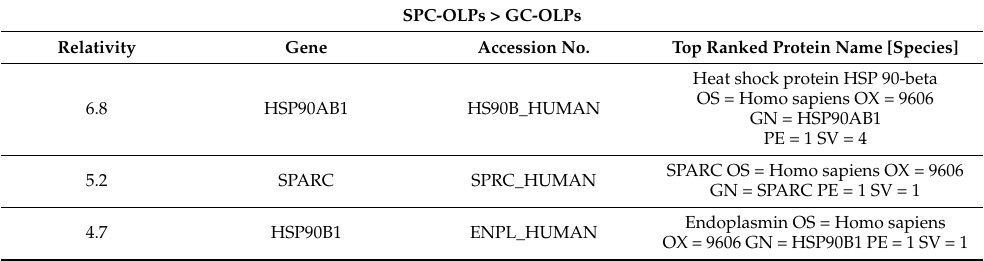
Table 2. Accession information showing the abundance of HSP90 αβ , SPARC, HSP90 β 1, and HSPA8 proteins in SPC-OLPs’ secretome that were significantly up-regulated with respect to GC-OLPs’